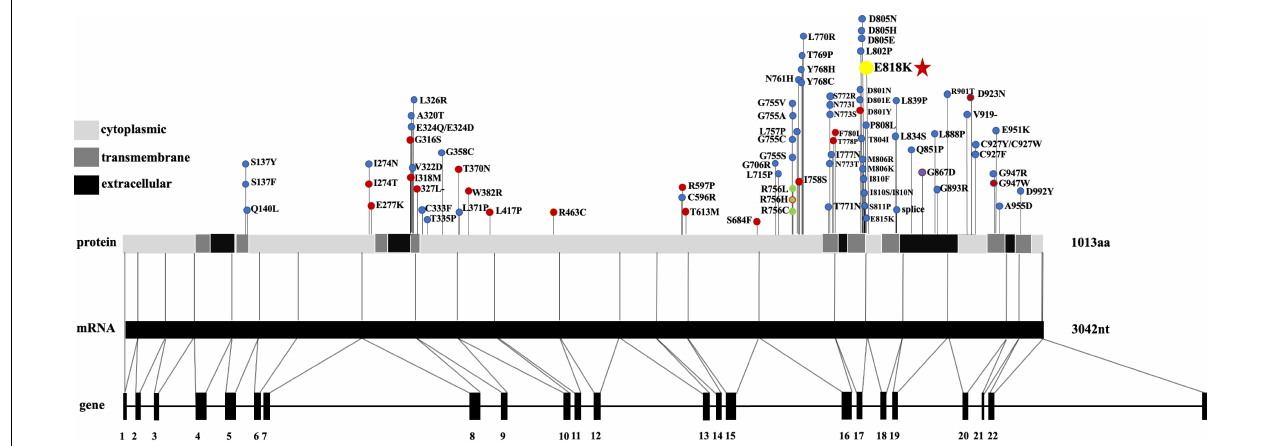
FIGURE 3 | The location of AHC-causing (blue dots), RDP-causing (red dots), and CAPOS-causing (yellow dots) mutations in ATP1A3 , mRNA, and protein. Three rare polymorphisms identified are indicated by the green dots. Mutation shared between different phenotypes is located at D923N (blue dot with a red dot inside), G867N (red dot with a blue dot inside), and R756H (red dot with a green dot inside). Different regions (cytoplasmic, transmembrane, and extracellular) of the protein are listed on the left. Abbreviations: AHC, alternating hemiplegia of childhood; CAPOS, cerebellar ataxia, areflexia, pes cavus, optic atrophy, and sensorineural hearing loss; RDP, rapid-onset dystonia